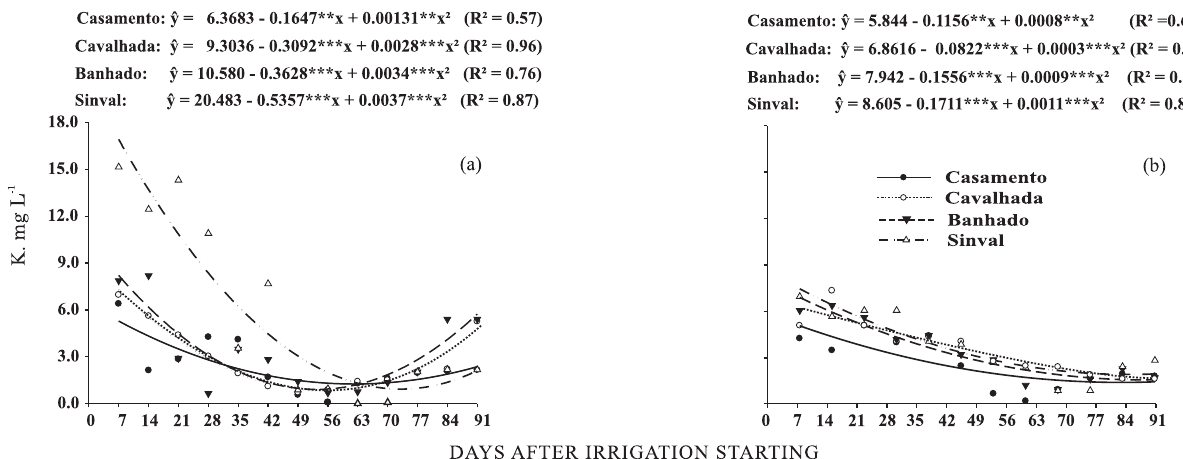
Figure 4. Potassium concentration in the water layer (a) and irrigation water (b), at the different sites. *, **, ***: significant at 10, 5 and 1%, by the F-test,